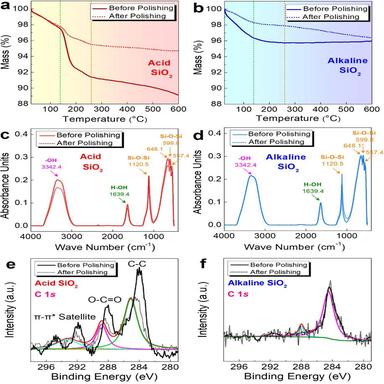
Comparison of the analysis on acid and alkaline SiO2 abrasives before and after 6 h polishing: TGA curves of (a) acid and (b) alkaline SiO2 abrasives from RT to 600 °C; IR spectra of (c) acid and (d) alkaline SiO2 abrasives, and XPS spectra of (e) acid and (f) alkaline SiO2 abrasives for C 1s. The scales of Y-axes for (a) and (b) are unified for comparison and nuclear magnetic resonance spectra of (g) acid and (h) alkaline SiO2 abrasives.